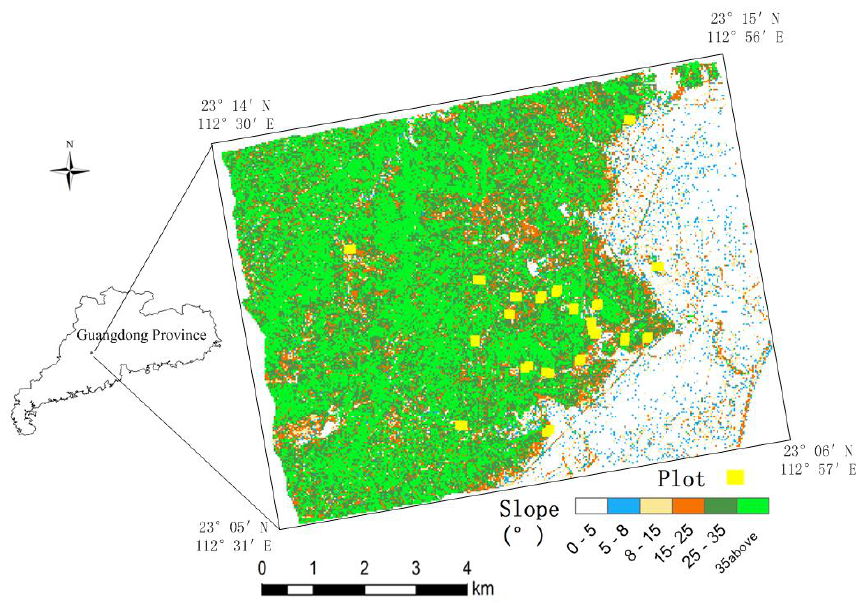
Figure 1. Distribution of slope in study area and plots.